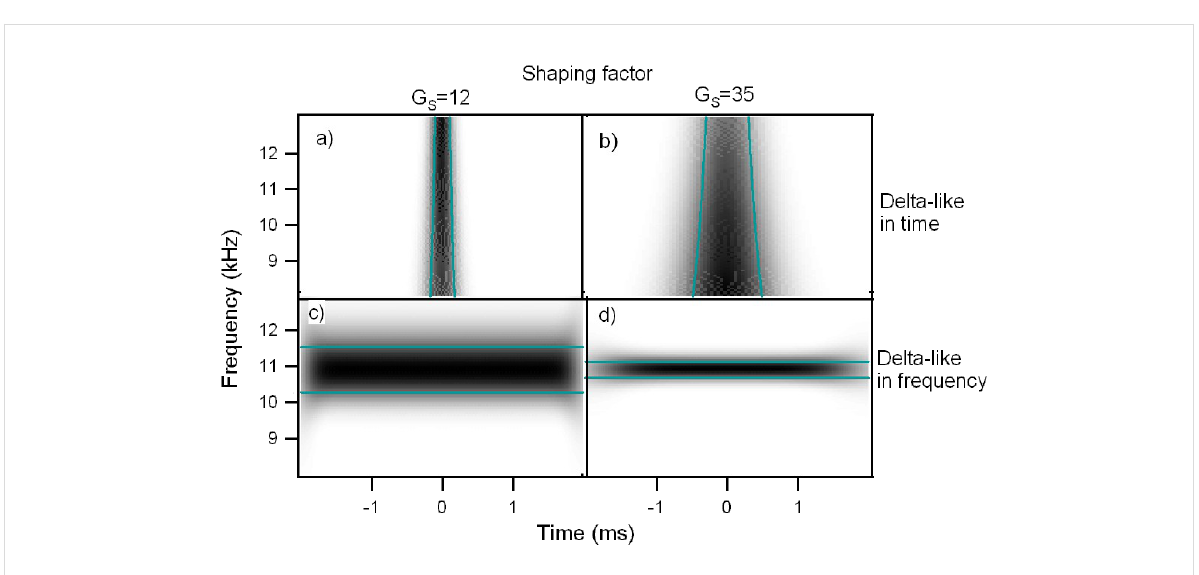
Figure 5: Continuous wavelet transform of a delta-like signal in time and a delta-like signal in frequency, analyzed with wavelets of different shaping factor, a-c) G S = 12, b-d) G S = 35. a-b) CWT of a delta-like function in time. The dependence of resolution on scale (frequency) is clearly shown. c-d) CWT of a delta-like function in frequency. The frequency resolution increases with the shaping factor. The degradation of the CWT resolution near the edges of the window transform is visible (edge